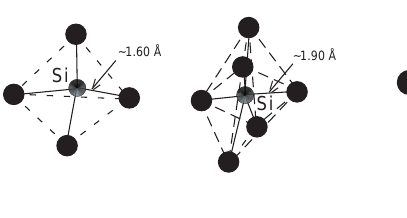
Figure 4a: Individual oxygen coordination polyhedra: SiO 4 tetrahedron (left) and MO 6 octahedron (M = metal cation, right).